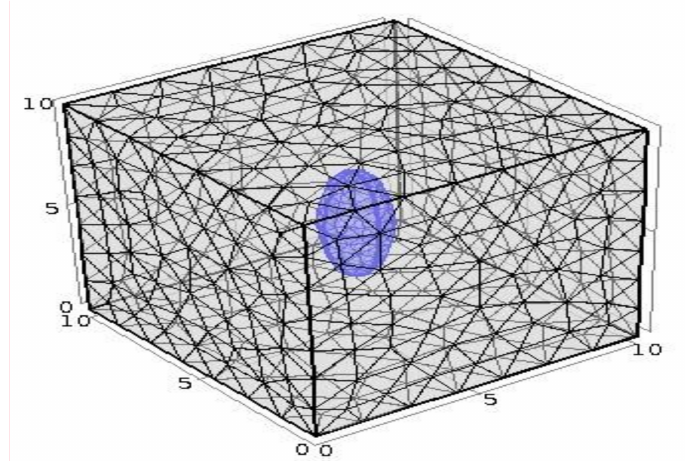
Figure 11. Displacement of the tips of an ellipsoid at 50 kV / mm.